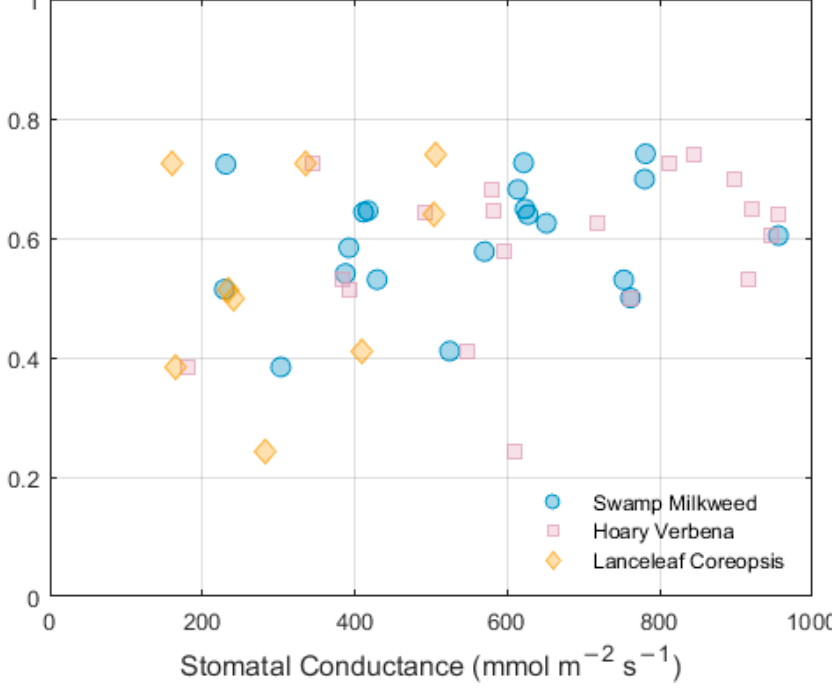
Figure 8. Relationships of the normalized greenness index with stomatal conductance from three species.